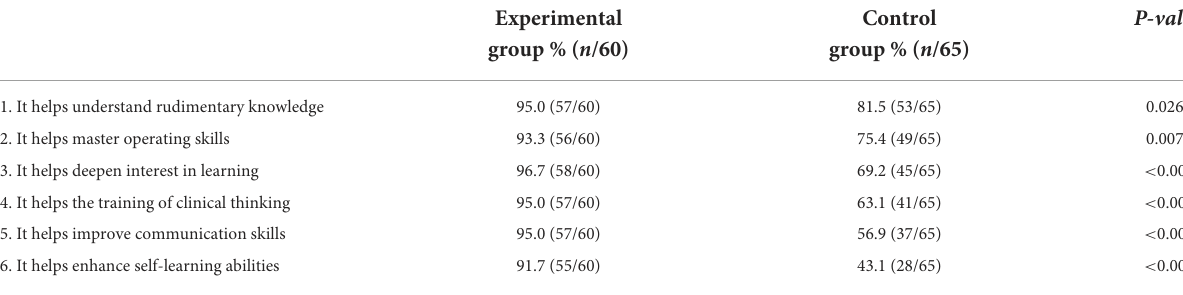
TABLE 5 Comparison of students’ satisfaction with the teaching effect between the two